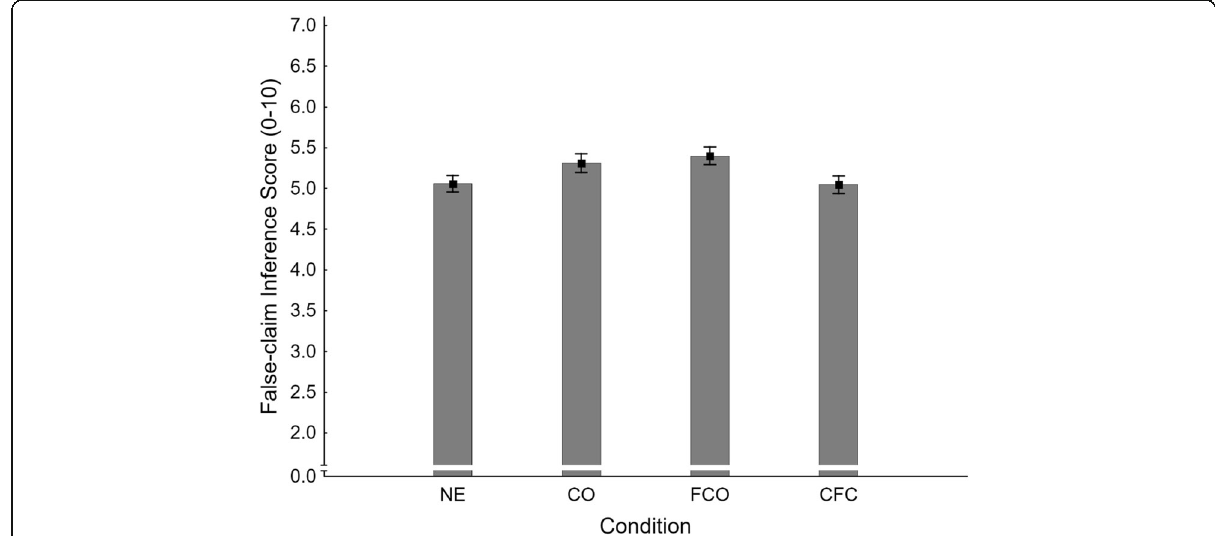
Fig. 3 Mean false-claim inference scores across conditions NE (no-exposure), CO (claim-only), FCO (fact-check-only), and CFC (claim-plus-fact- check) in Experiment 1. Error bars show standard errors of the